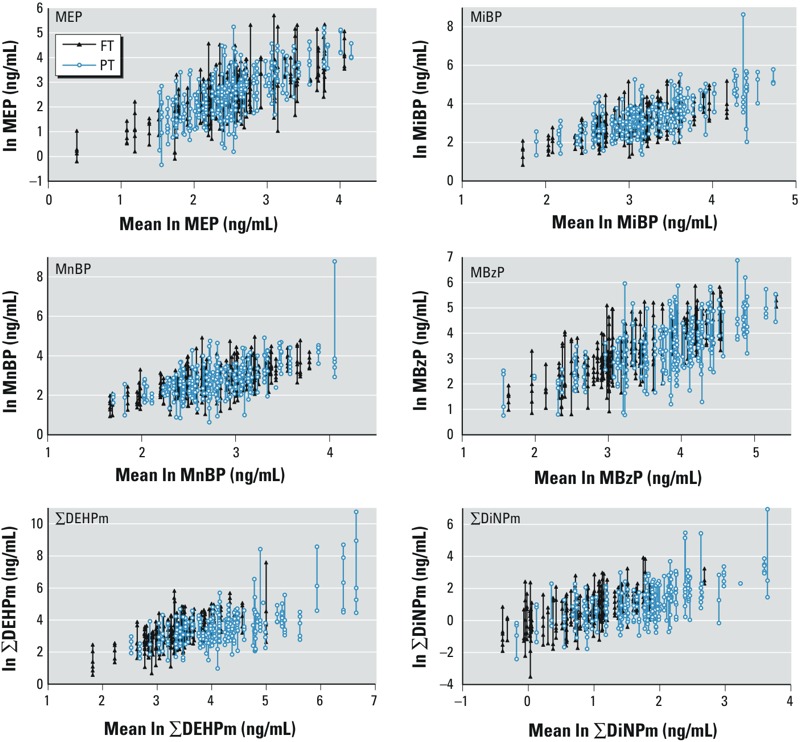
Within-subject variation of urinary phthalate metabolite levels in 58 FT infants (307 samples) from M1–M6 and 67 PT infants (290 samples) from M2–M6 for MEP, MiBP, MnBP, MBzP, ∑DEHPm, and ∑DiNPm. Vertical lines with dots represent individual samples of the same infant (y-axis) versus the infant’s mean phthalate metabolite level (x-axis). All concentrations were ln-transformed. Phthalate metabolite concentrations for PT infants at M1 were not included, because PT infants at M1 mostly were hospitalized, whereas only seven and five infants still were hospitalized at M2 and M3, respectively.